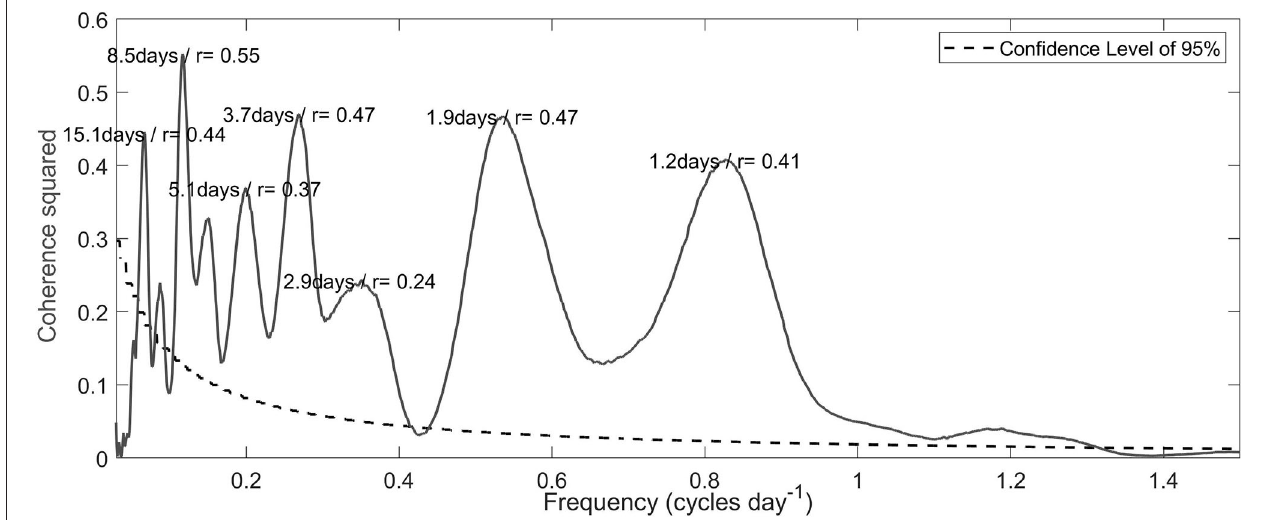
FIGURE 7 | Cross spectrum showing coherence squared between surface U-momentum wind stress and detided modeled transport of the d’Urville Current for the entire timeseries (April 2009 to September 2012). The 95% confidence limits denoted by dashed line. Period and coherence squared values labeled for each peak.